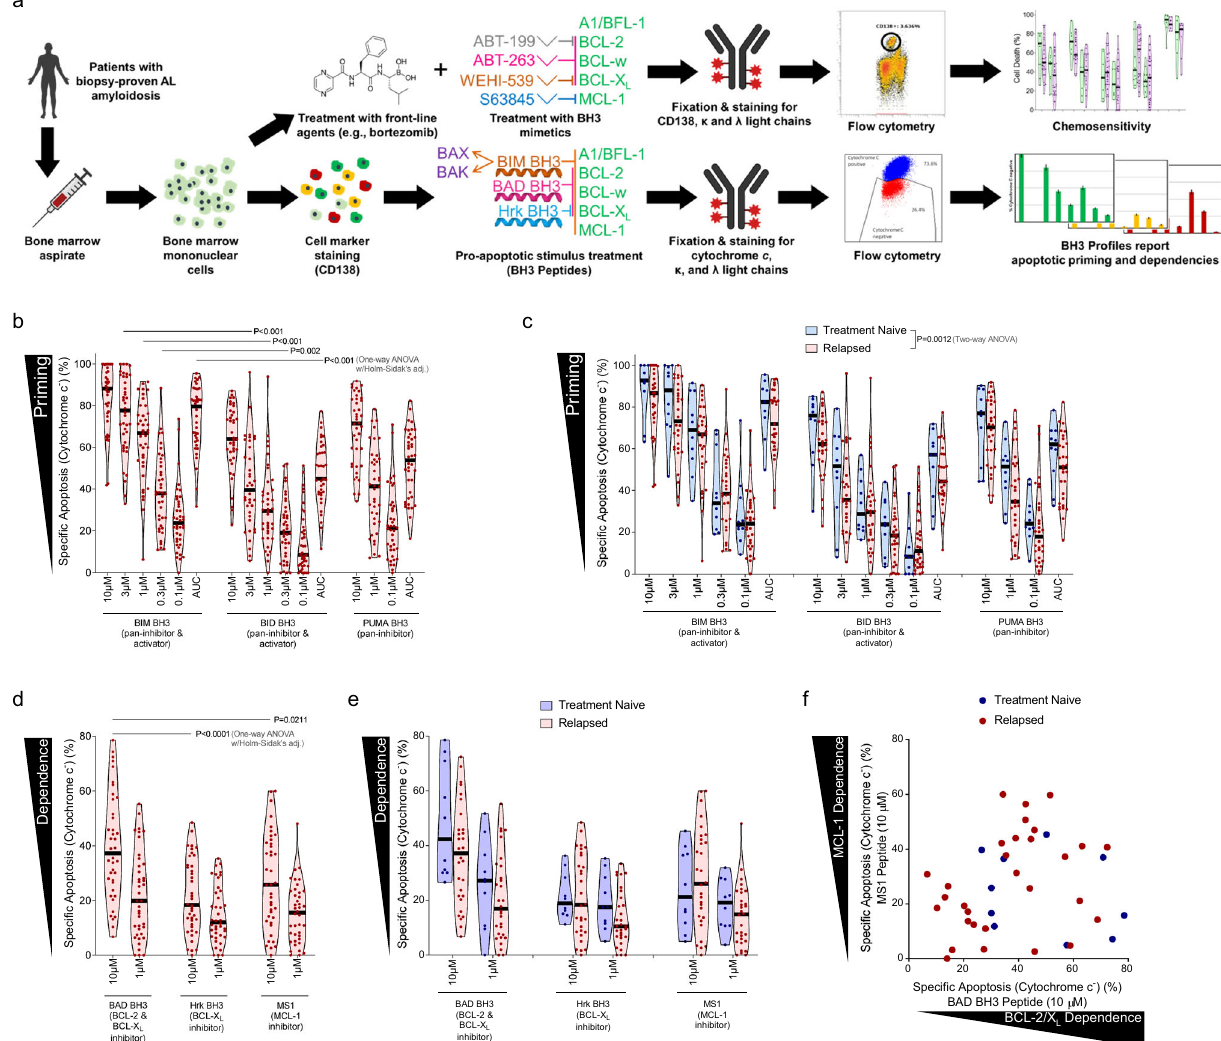
Fig.1|PlasmacellsfrompatientswithALamyloidosisareprimedforapoptosis and dependent on pro-survival proteins based on BH3 pro fi ling. a Analysis overview: mononuclear cells were isolated from bone marrow aspirates from patients diagnosed with AL amyloidosis. One portion was stained with anti-CD38 and anti-CD138 antibodies then permeabilized with digitonin and exposed to BH3 peptides. After 60minutes of exposure, cells were fi xed and stained with anti-